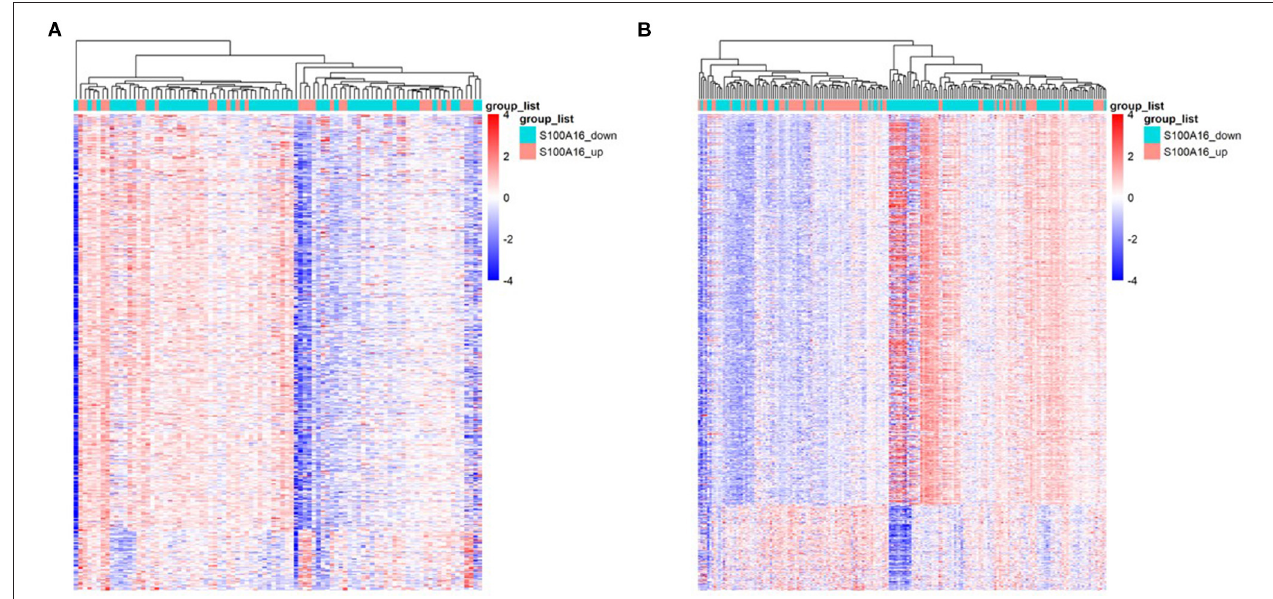
FIGURE 7 | Heat map of DEGs when S100A16 is down-regulated and up-regulated in PDAC based on TCGA database (A) and ICGC database (B) .